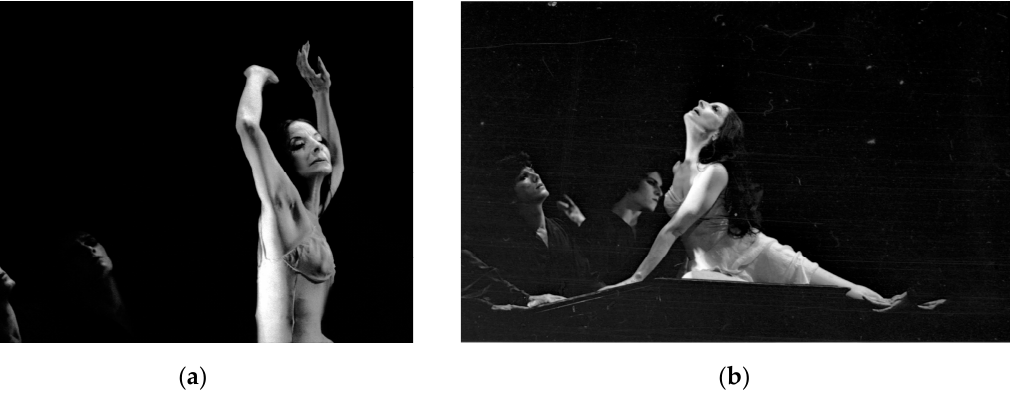
Figure 5. ( a,b ): Alicia Alonso in La Diva . Festival de Ballet de La Habana, November, 1986. Photo by Alicia Sanguinetti. Published with the kind permission of Alicia Sanguinetti.